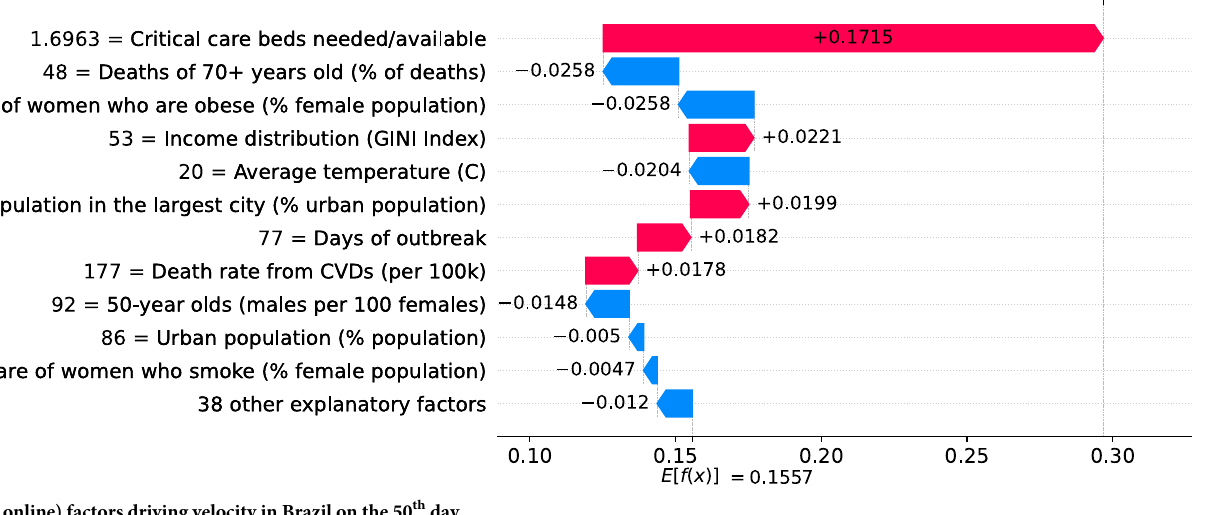
Fig 36. (Color online) factors driving velocity in Brazil on the 50 th